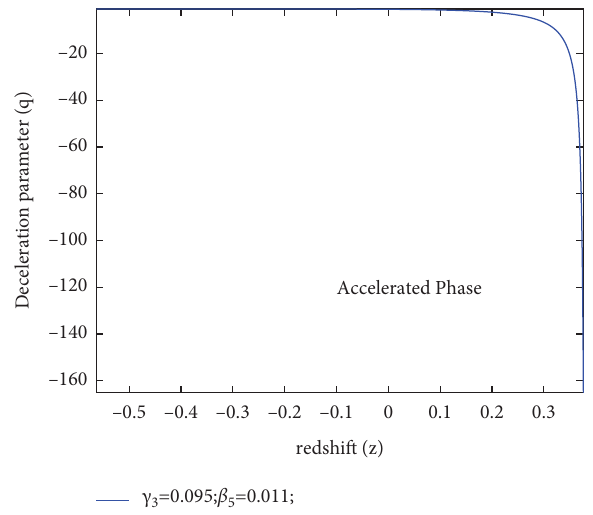
Figure 11: Deceleration parameter ( q ) versus redshift ( z ) for BT-IX.